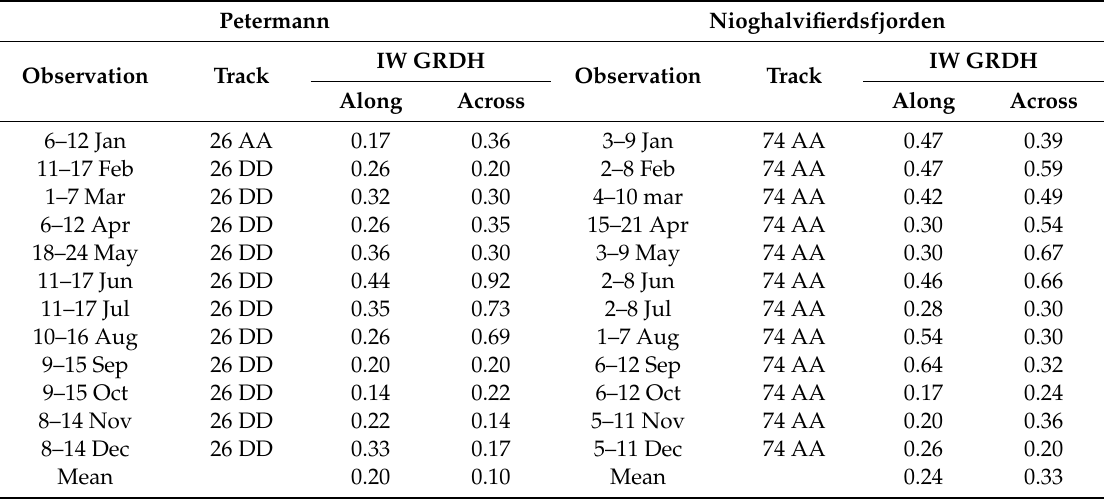
Table 13. RMSE (expressed in m / day) for the displacement velocities calculated with the in-house OT algorithm with respect to reference IW SLC results for the PG (left panel) and NI (right panel).